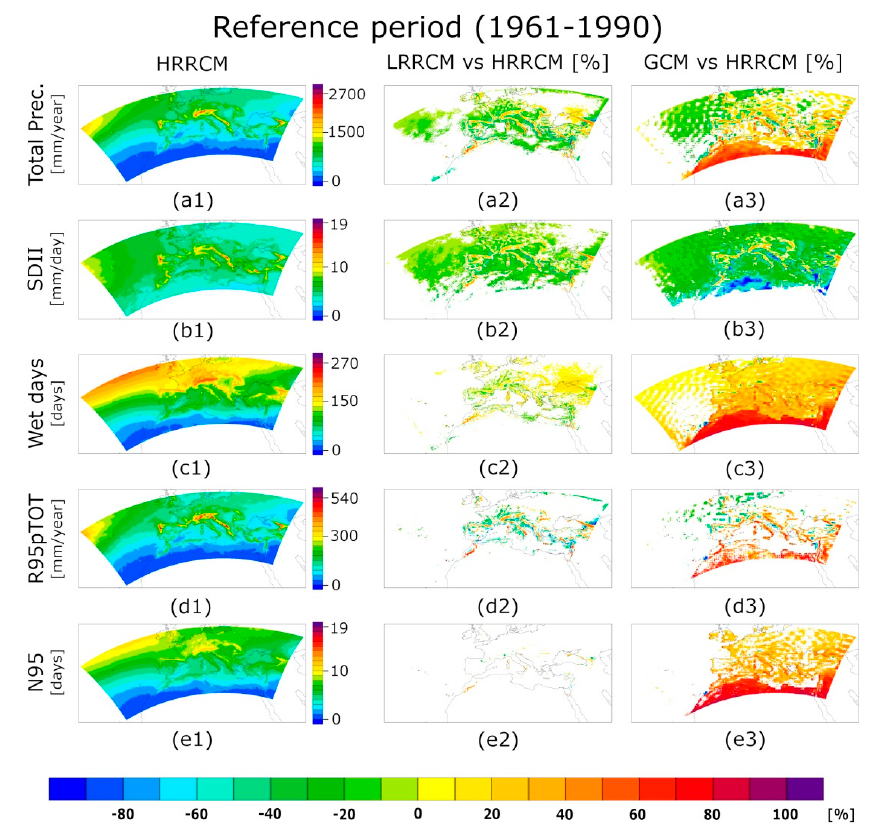
Figure 2. Precipitation indices: comparison among model simulations for the reference period. Left column shows the pattern values of 5 precipitation indexes defined in Section 2.2, as obtained in the high-resolution regional simulation (HRRCM). Middle and right columns show the differences of HRRCM with respect to the low-resolution regional simulation (LRRCM) and the global simulation (GCM). Positive values denote areas where the HRRCM produces higher values. White areas denote points where di ff erences are not significant ( a1 – a3 ), annual total precipitation; ( b1 – b3 ), SDII index; ( c1 – c3 ), annual number of wet days; ( d1 – d3 ), annual total precipitation amount when daily precipitation is greater than 95th percentile; ( e1 – e3 ), number of days when RR ≥